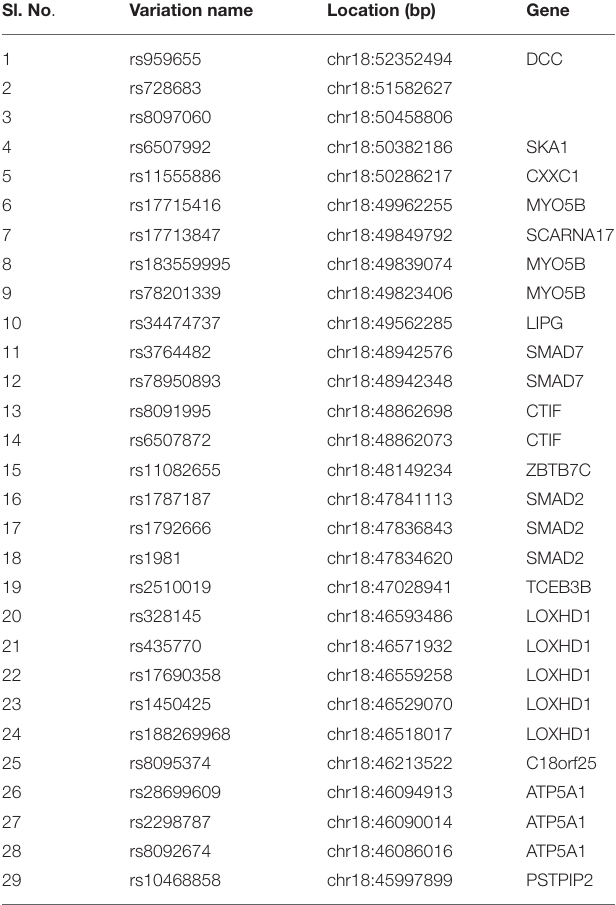
TABLE 1 | List of SNPs selected for Sequenom iPLEX genotyping. Sl. No